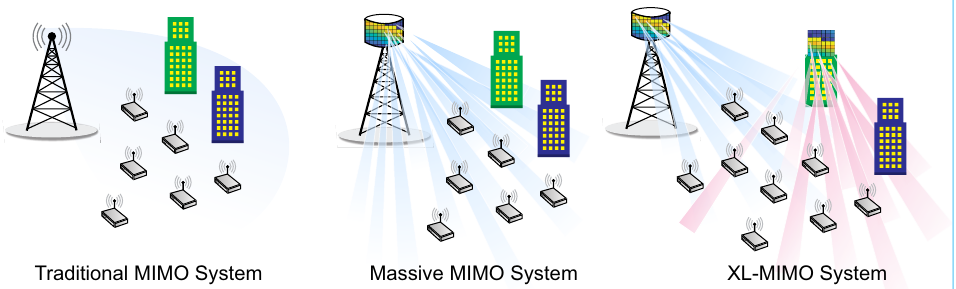
Figure 2. Comparison between traditional MIMO system, massive MIMO systems, and XL- MIMO